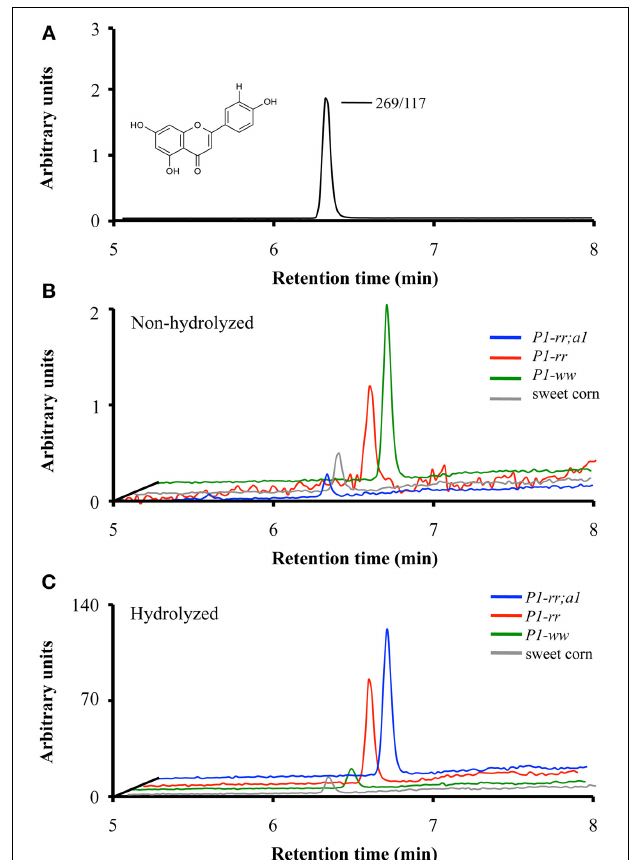
FIGURE 3 | Apigenin content in whole maize kernels. LC-MS/MS analyses of parental/daughter transitions corresponding to apigenin (268.9/117.0) for P1-rr (red); P1-rr;a1 (blue); P1-ww (green) at 14 DAP and sweet corn (gray) at milky stage. (A) Chromatogram corresponding to apigenin standard. (B) Chromatograms corresponding to apigenin content in non-hydrolyzed P1-rr ; P1-rr;a1 ; P1-ww and sweet corn. (C) Chromatograms corresponding to apigenin content in hydrolyzed samples. Arbitrary units correspond to peak intensity for the 268.9/117.0 transitions in counts per